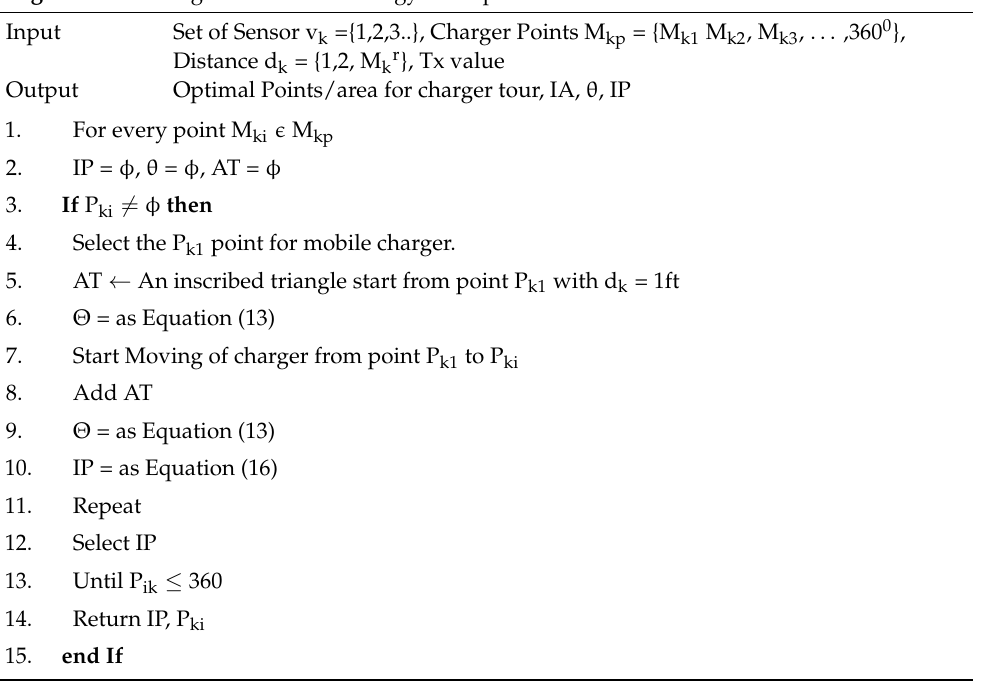
Algorithm 1 : Charger Placement Strategy for Dipole antenna.